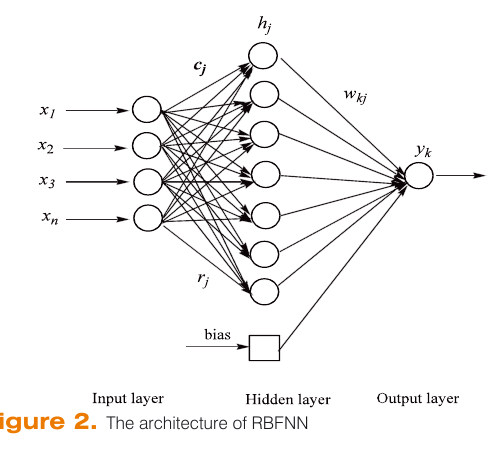
Figure 2. The architecture of RBFNN